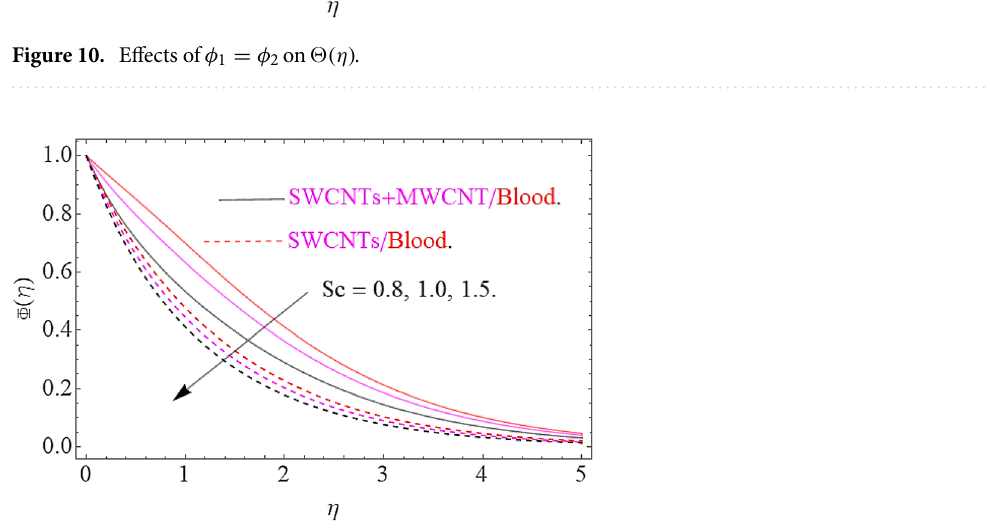
Figure 11. Impact of Sc on �(η)